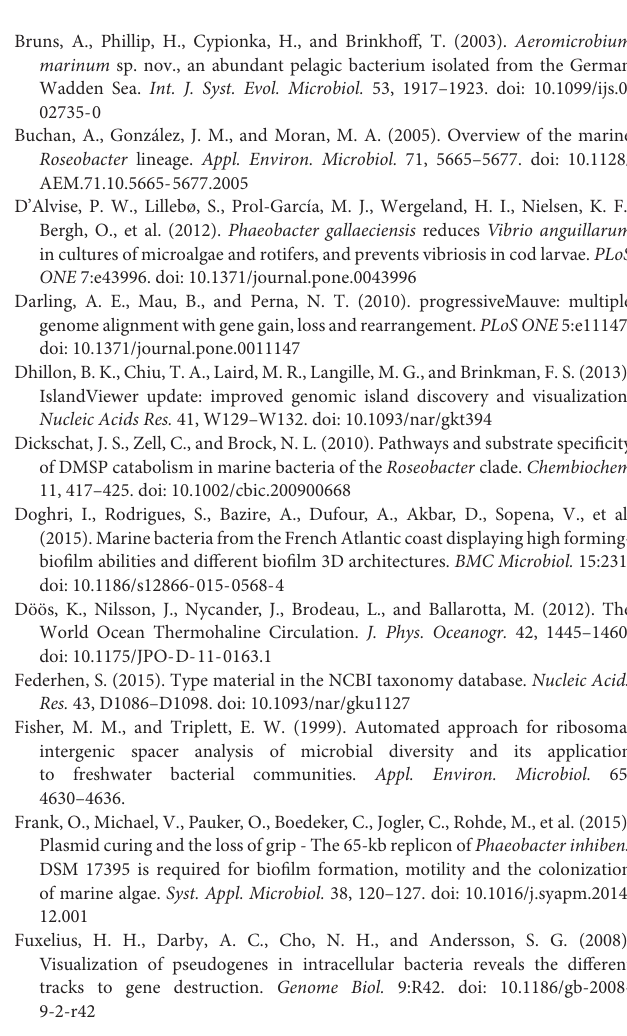
FIGURE S1 | Flow scheme of combined methods applied in the current study. FIGURE S2 | Distribution of nucleotide diversity (Pi) per gene between P. gallaeciensis clades ordered along the genome of P75 by means of the locus_tag